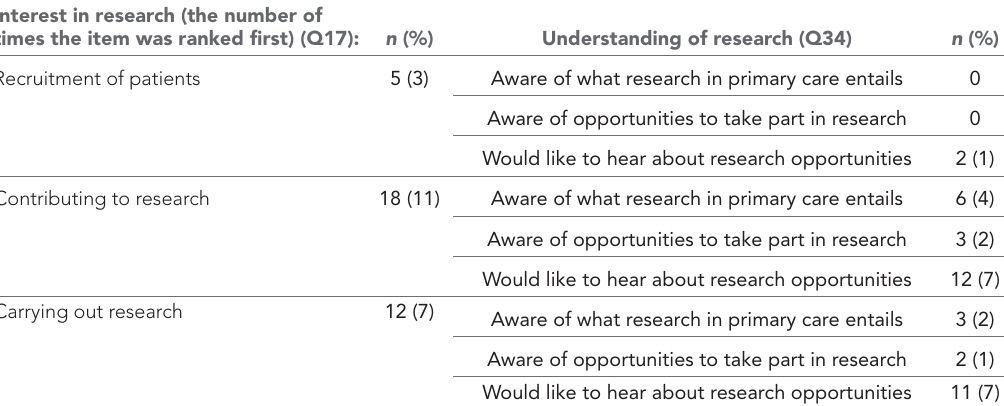
Table 6 Trainee interest and understanding of research ( n = 164) Interest in research (the number of times the item was ranked first)